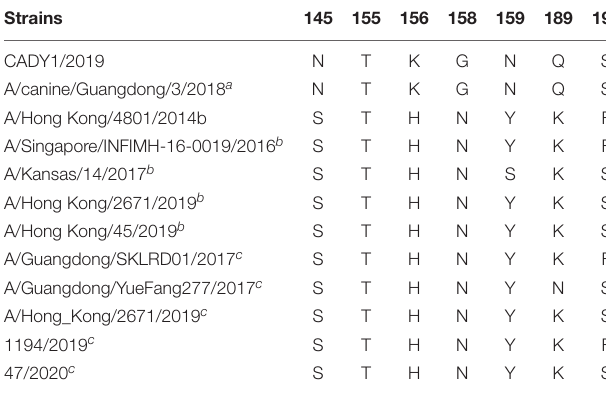
TABLE 2 | Key antigen residues of H3N2 viruses.